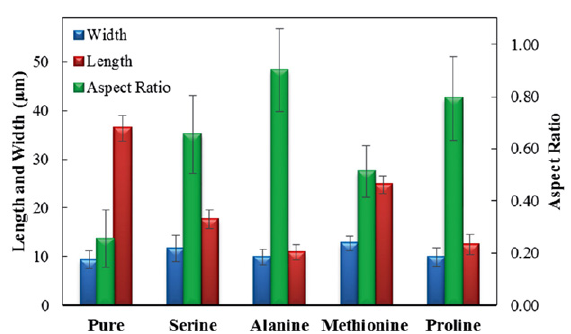
Figure 5. The width, length, and aspect ratio of CTT crystals ob- tained in pure media and in the presence of 200 ppm serine, alanine, methionine, and